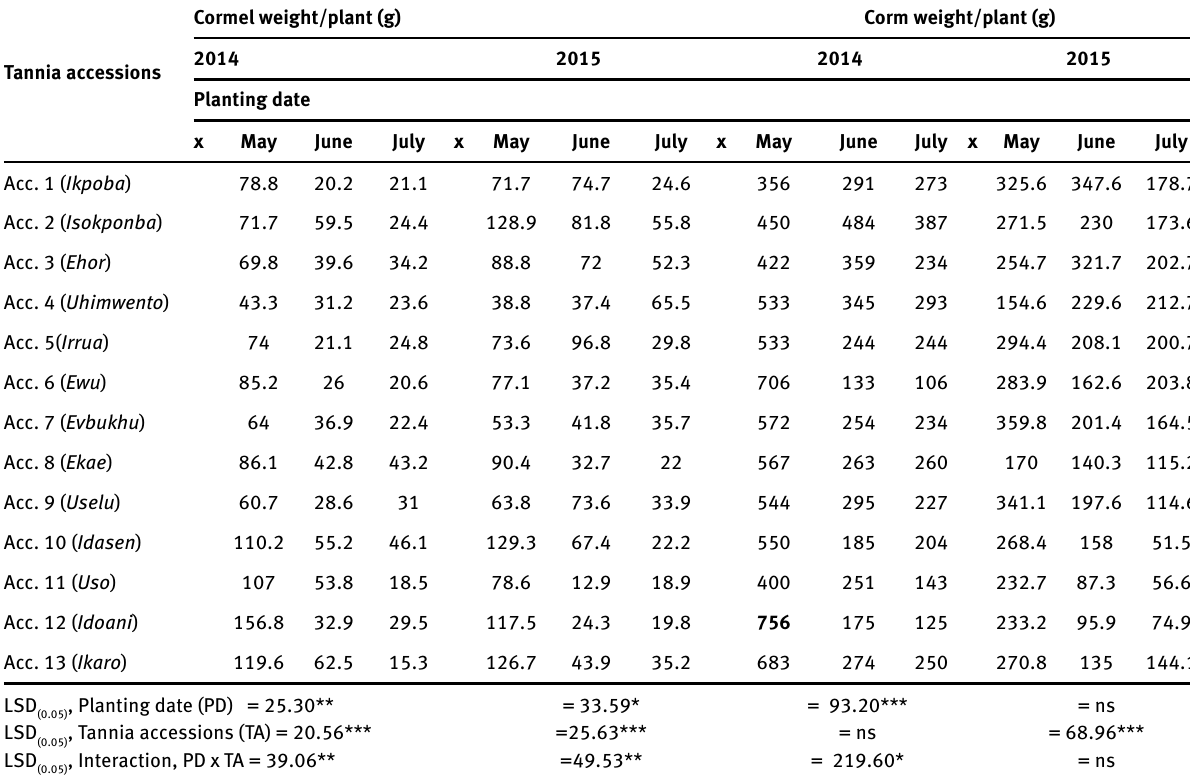
Table 7: Effect of interaction between planting date and tannia accessions on cormel weight/plant and corm weight/plant in 2014 and 2015 cropping seasons